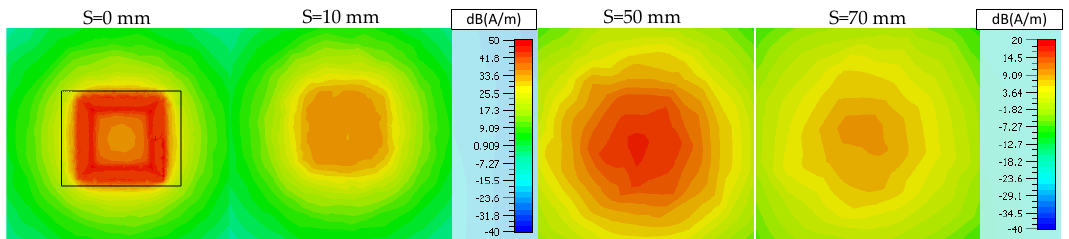
Figure 11. Simulated magnetic near-field at various separations s from the surface of the